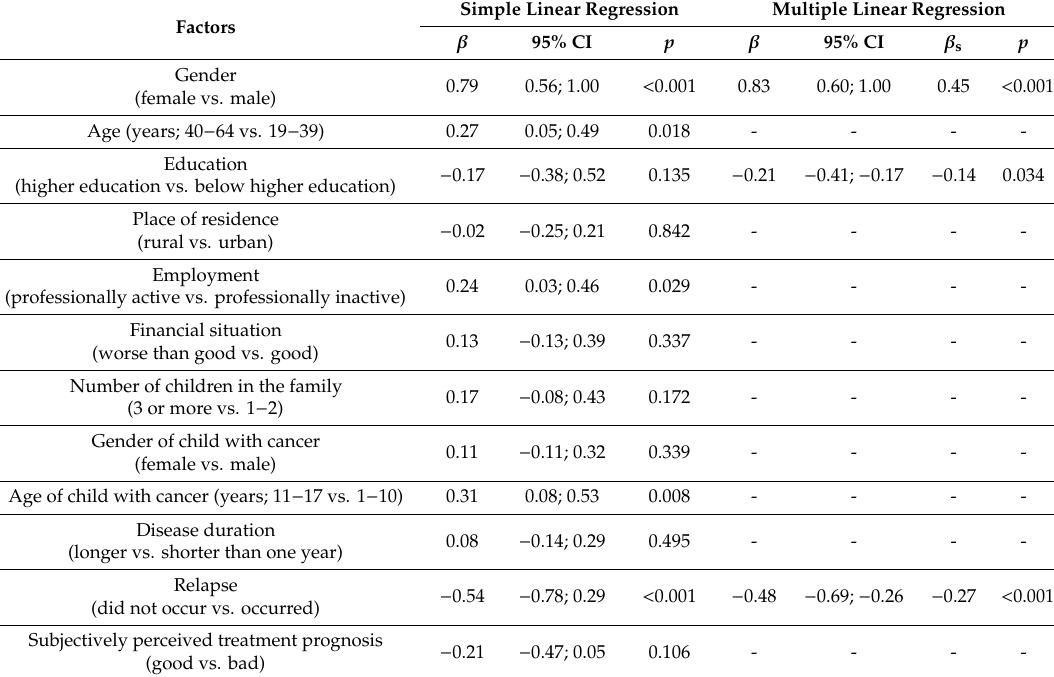
Table 5. Factors predicting parental PTSS by simple and multiple linear regression models. Simple Linear Regression Multiple Linear Factors